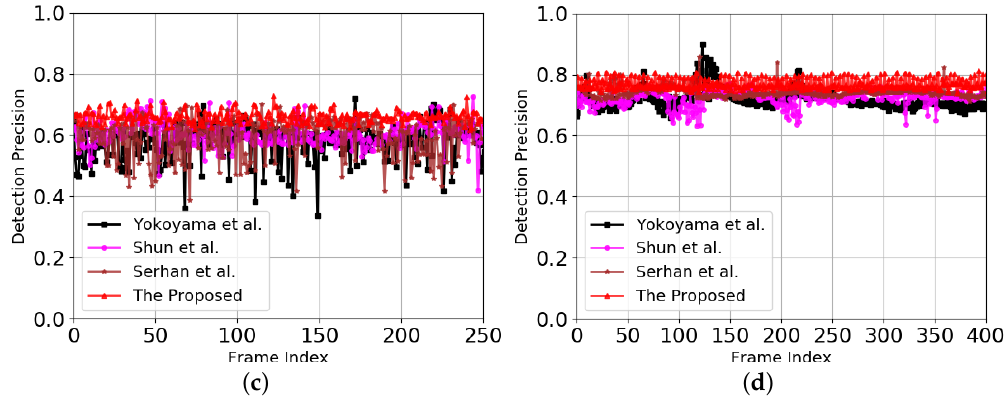
Figure 15. Detection precision curves for test sequences among different motion vector extraction methods. ( a ) Akiyo (250 frames); ( b ) Carphone (300 frames); ( c ) Pedestrians (250 frames); ( d ) Salesman (400